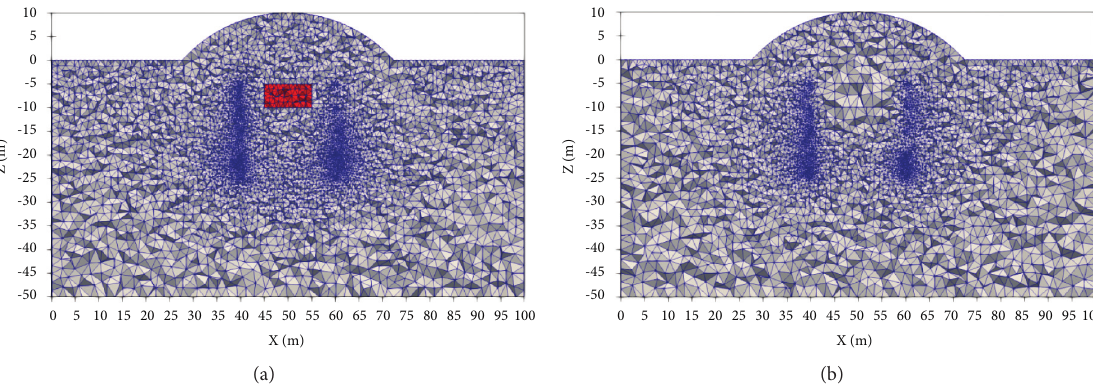
Figure 13: Forward and inversion grid of buried rectangular model under mountain topography. (a) Forward mesh; (b) inversion mesh.